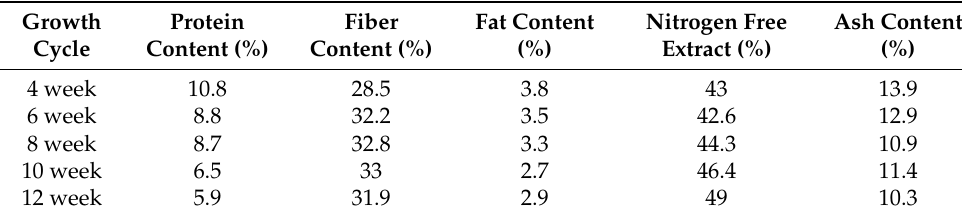
Table 2. The content of major composition in